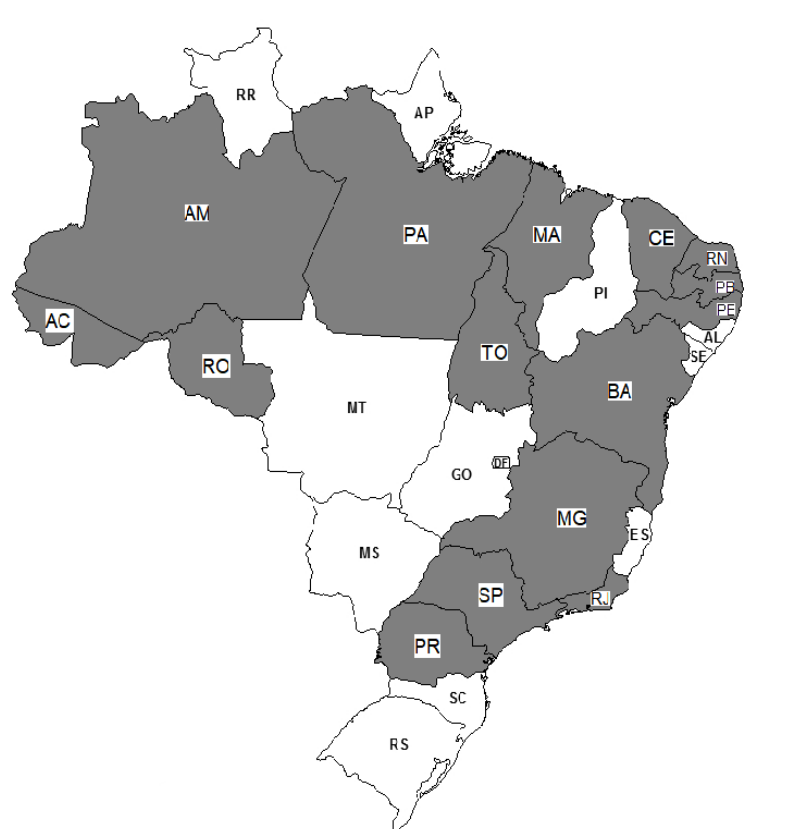
FIGURE 2 - States with knowledge of Notivisa greater than national